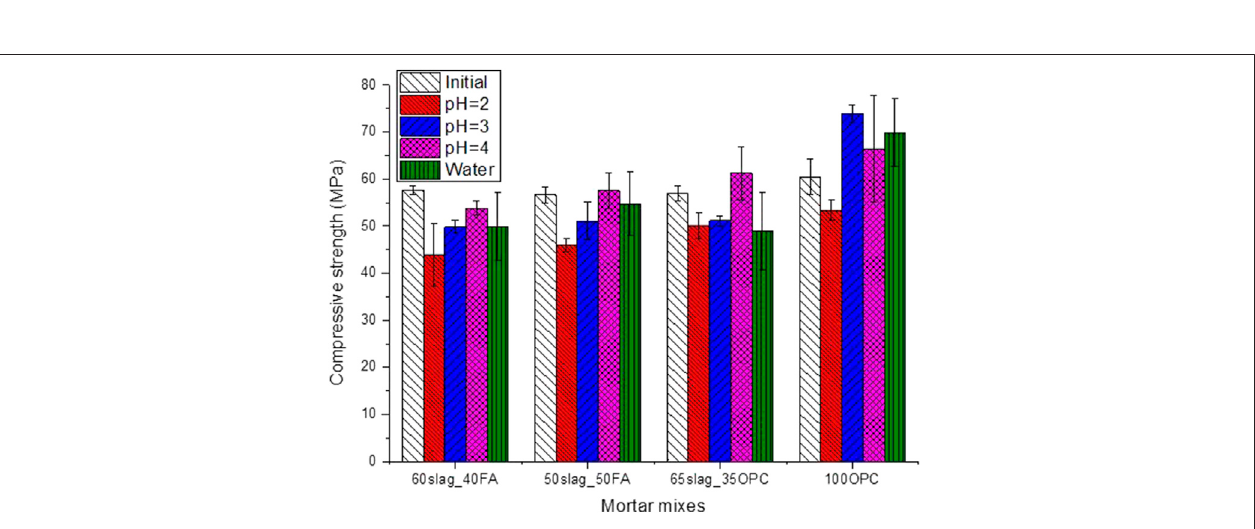
Frontiers in Materials |